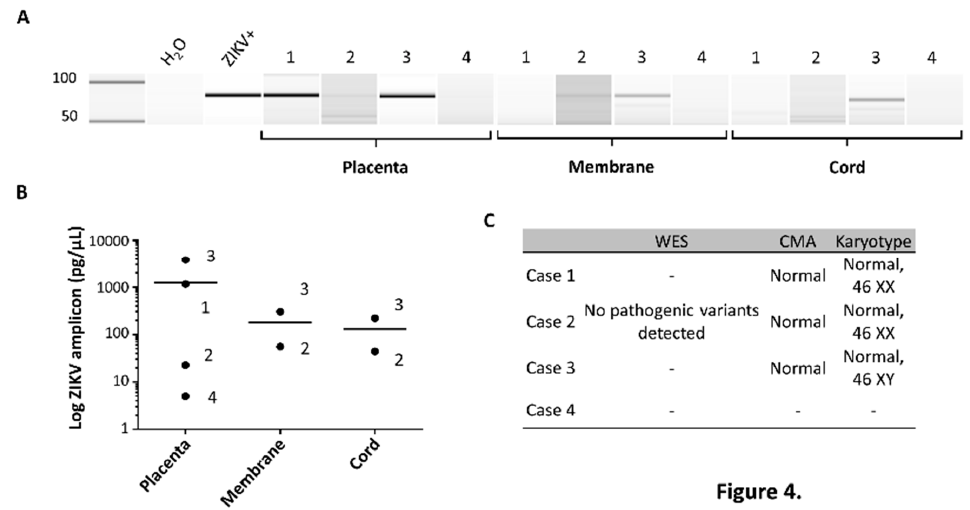
Figure 4. NAT-based assessment of non-formalin fixed placental, membrane, and/or umbilical cord tissue for ZIKV demonstrates detectable viral RNA in congenital Zika syndrome-affected cases, but not in the unaffected case. ( A ) ZIKV NAT in placental, membrane, and cord specimens. ZIKV was detected by NAT in all placental specimens in Cases 1, 2, and 3 (congenital Zika syndrome-affected) but not Case 4 (unaffected). ZIKV was detected in the membranes and cord of Cases 2 and 3 by NAT, but not Cases 1 nor 4. Heat killed conditioned media from Vero cells, with actively replicating clinical isolate ZIKV (20), served as a positive control (ZIKV+), and water as a negative control (H 2 O). ( B ) Quantitative bioanalysis band chromatograms from NAT. Quantitation of ZIKV (74 nt) in relative log measures by NAT was determined employing the Agilent BioAnalyzer. ( C ) Absence